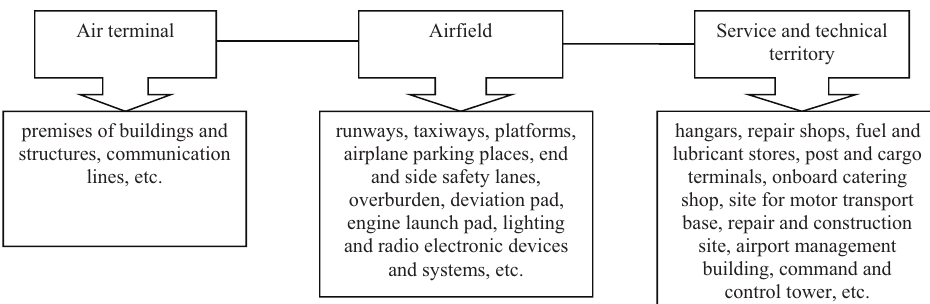
Figure 1. The constituent structures of the airport complex by location and function